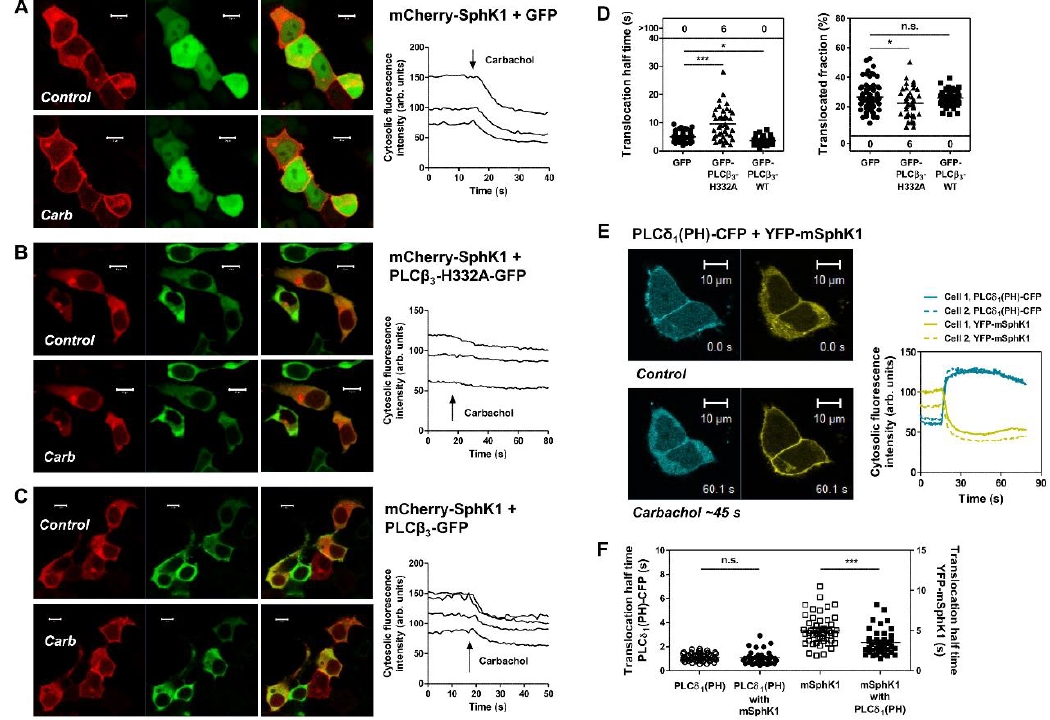
Figure 2. Influence of PLCβ 3 and PLCδ(PH) on M 3 receptor-induced SphK1 translocation. HEK-293 cells stably expressing the M 3 receptor were transfected as indicated. ( A – D ) Cells were transfected with mCherry-hSphK1 (red) and GFP ( A ), catalytically inactive PLCβ 3 (PLCβ 3 -H332A-GFP) ( B ) or PLCβ 3 wild-type (PLCβ 3 -WT) ( C ). Representative images were taken at high spatial resolution immediately before and after the acquisition of time series during which only mCherry fluorescence was monitored at 1 image/s. The line graphs showing time courses of cytosolic fluorescence intensity correspond to the cells shown in the images. Carbachol was added at the indicated time points. ( D ) SphK1 translocation half-times were measured by fitting exponential curves to the decay in cytosolic fluorescence. The translocated fraction represents the decay in cytosolic fluorescence intensity in % of initial fluorescence. Each dot represents a single cell. Translocation half-times >100 depict the number of cells which did not respond. Note: n.s., not significant; * p <0.05, *** p < 0.0001 in t-tests with Welch’s correction for unequal variances. ( E , F ) Cells were transfected with PLCδ(PH)-CFP (cyan), YFP-mSphK1 (yellow), or both. Carbachol-induced translocation of the two proteins was studied in time series with ~3–4 images/s. ( E ) Images were taken from a representative time series with double-transfected cells before and ~45 s after addition of carbachol. The line graph shows the time course of cytosolic fluorescence intensity for both CFP and YFP. ( F ) Translocation half-times for PLCδ(PH)-CFP and YFP-mSphK1, both alone and in combination. Note: n.s., not significant; *** p < 0.0001 in t-tests with Welch’s correction for unequal variances. Micrometer bars, 10 µm.